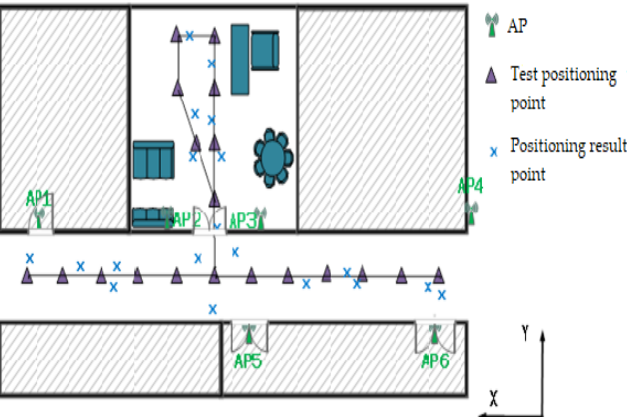
Figure 14. Schematic diagram of track points of test mobile terminal 1 positioning results.